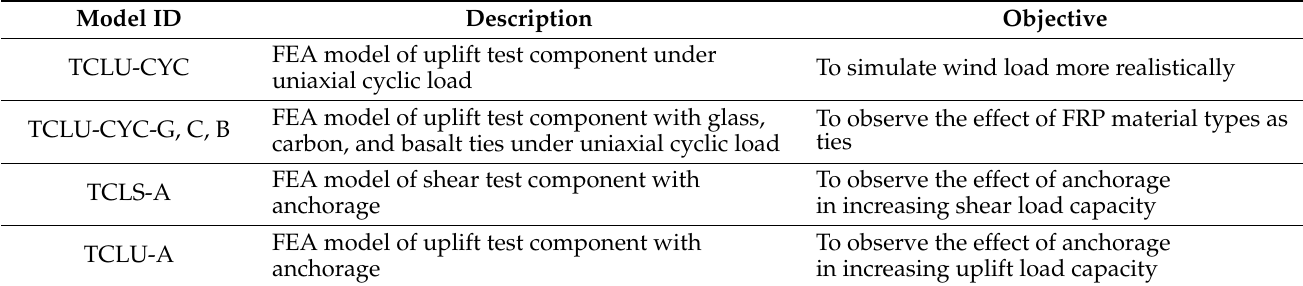
Table 2. Parameters under study.